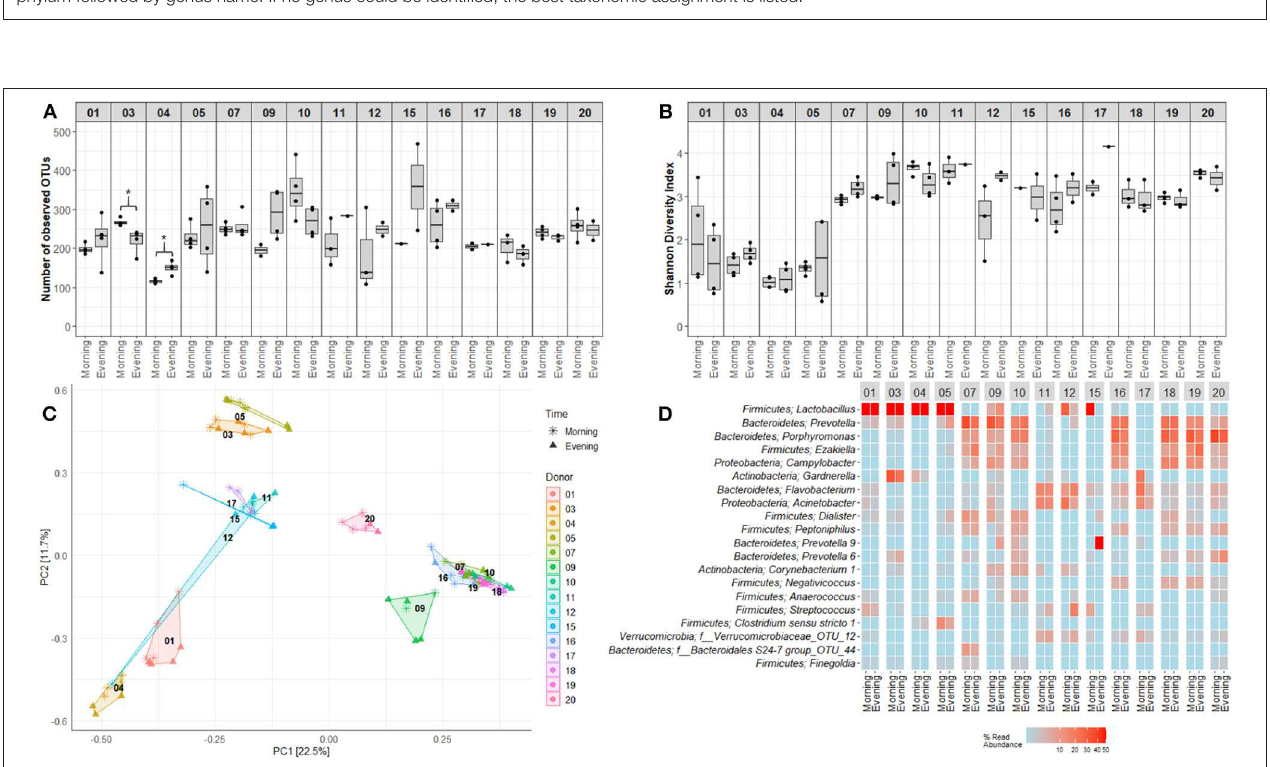
FIGURE 6 | Within day variations in voided urinary microbial alpha and beta diversity. Visualization of variations and similarities between voided urine samples collected morning and evening within each study participant. (A) OTU richness showing numbers of unique OTUs in samples obtained morning and evening. (B) Shannon Diversity Index visualizing differences and similarities in diversity of OTU. (C) Distribution of samples collected mornings and evenings, using PCA of Hellinger transformed OTU abundances. Colors and numbers indicate study participant while point shape indicate collection time point. (D) Heat maps depicting the 20 most common OTUs in samples collected mornings and evenings. Each name consists of phylum followed by genus name. If no genus could be identified, the best taxonomic assignment is listed. For this part of the study, two donors, one girl (donor 8) and one man (donor 13), were excluded, since a complete set of matching evening-morning samples were lacking (due to quality control measures). Donors 01–05 were adult women (18–50 years), 06–10 girls (5–10 years), 11–15 adult men (18–50 years), and 16–20 were boys (5–10 years). * p < 0.05.